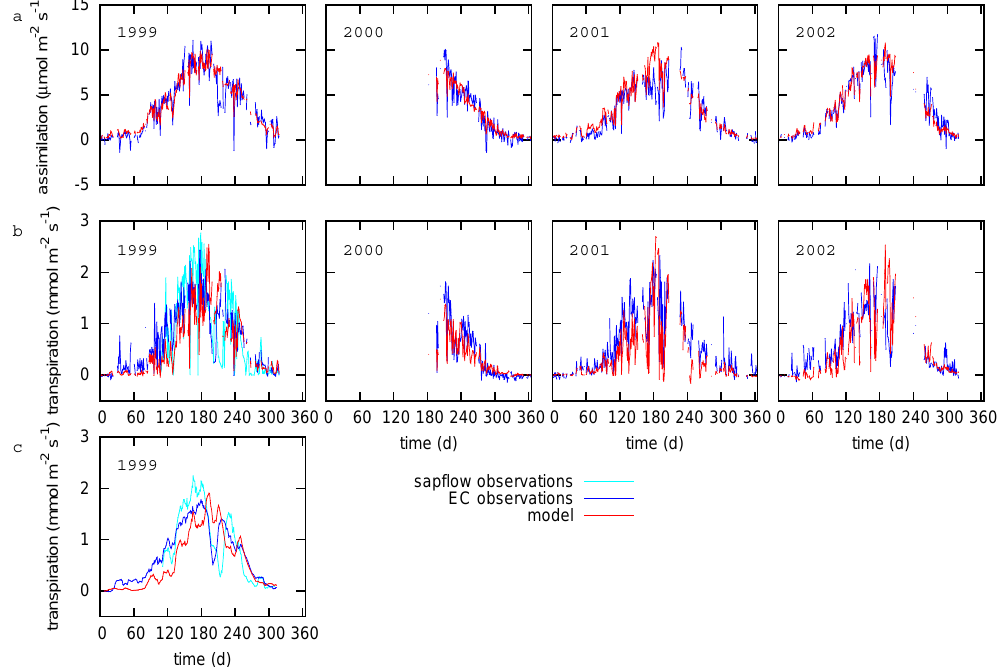
Figure 2. Annual cycle of simulated and observed daily mean (a) CO 2 assimilation and (b) transpiration for the years 1999–2002. Note that the photosynthesis parameterisation was based on observations from 2001 (Thum et al., 2008). Days with fewer than 45 (out of 48) half-hourly observations were omitted. (c) 10day running mean of simulated and observed daily mean transpiration for 1999.